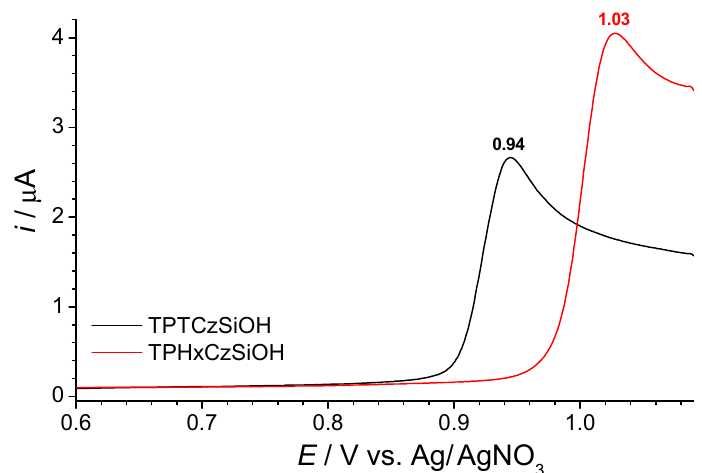
Figure 4. First anodic sweep voltammograms for 0.1 mM of tris(4-(carbazol-9-yl)phenyl)silanol (TPTCzSiOH) (black line) or tris(3,5-di(carbazol-9-yl)phenyl)silanol (TPHxCzSiOH) (red line) and 0.1 M tetrabutylammonium perchlorate solutions in MeCN/methylene chloride (1:4) at platinum disc